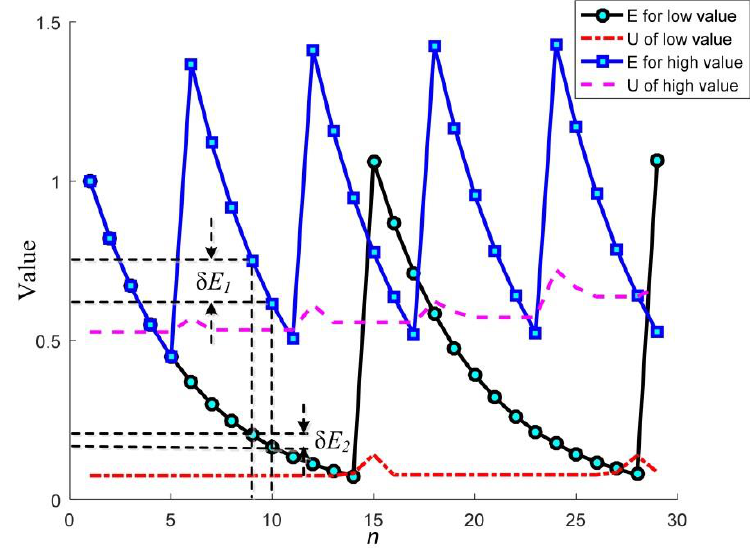
Figure 5. The exponential attenuation characteristic of the PPCNN model.